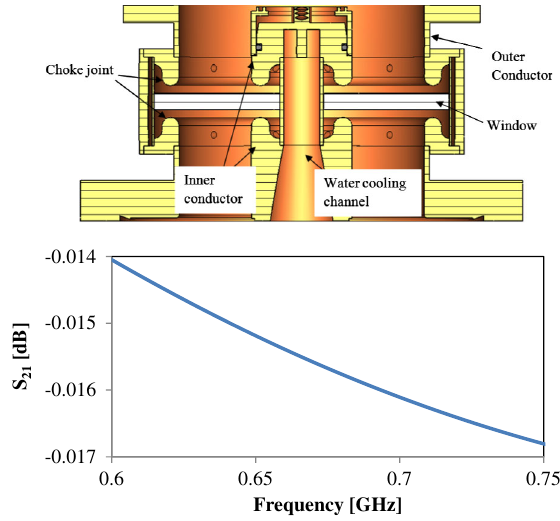
FIG. 3. Top: the planar rf window assembly; bottom: S21 parameter of the rf